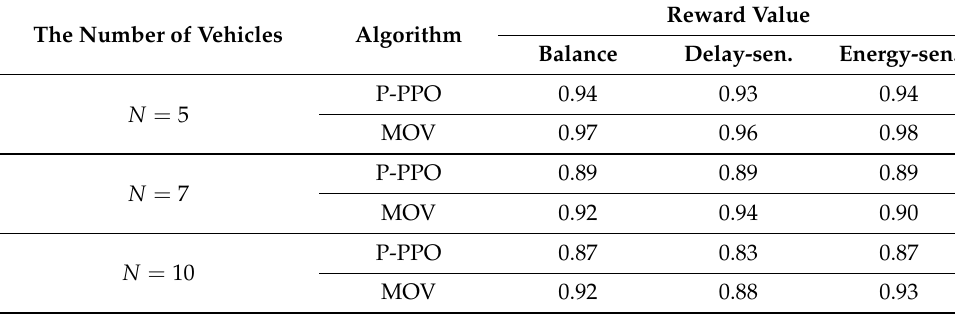
Table 4. Reward values when using different algorithms with different numbers of vehicles.